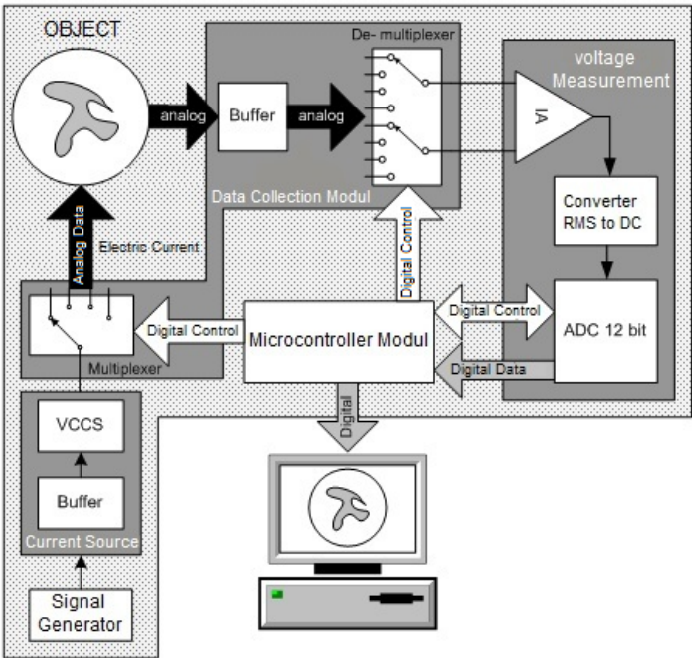
Figure 2: Data acquisition of electrical impedance tomography